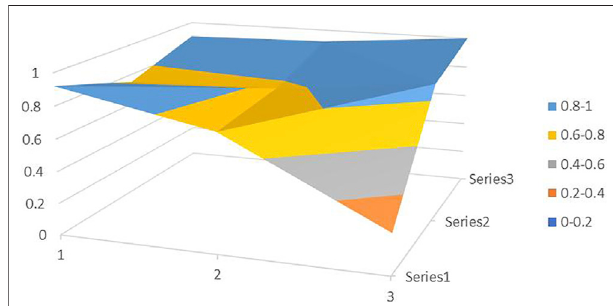
FIGURE 4 | Average PMC Index Surface Chart of Singapore ’ s National Park First-level Policy